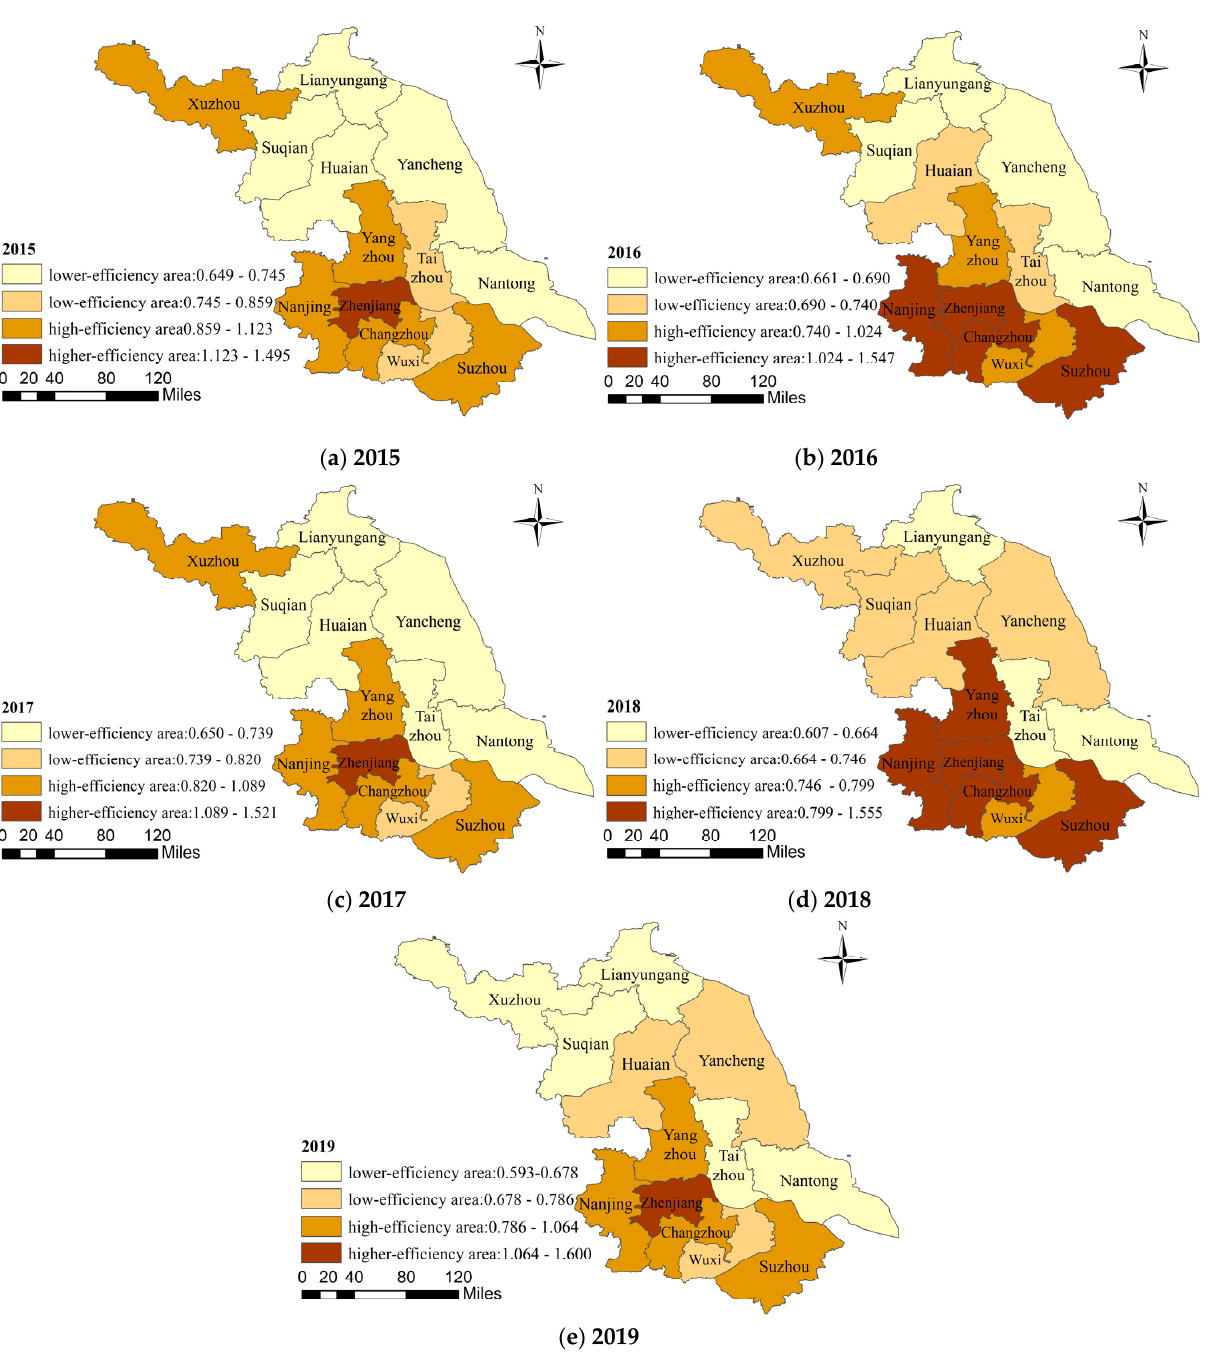
Figure 3. The spatial distribution of medical and health services efficiency in Jiangsu Province from 2015 to 2019.